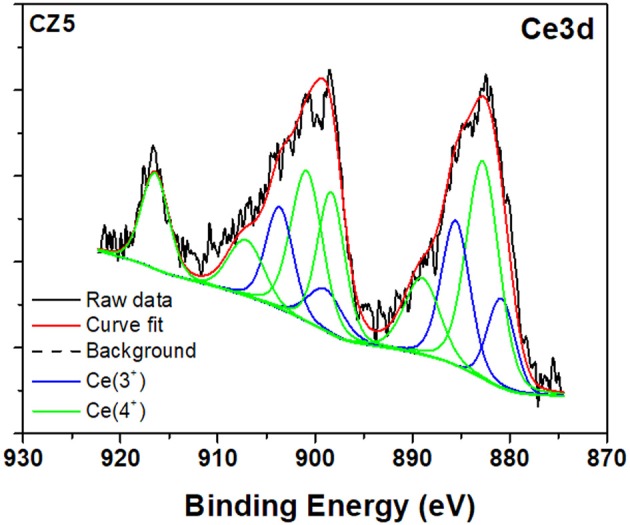
XPS high-resolution spectrum on Ce3d for 5% Ce-doped zirconia.